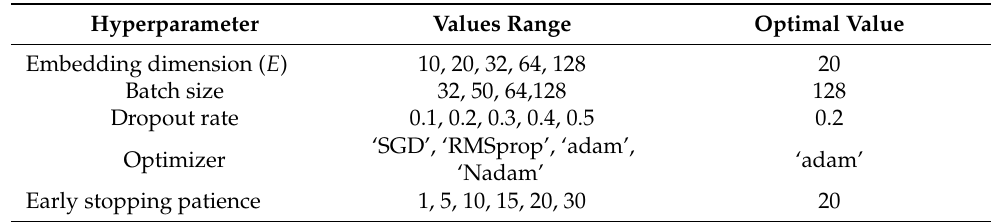
Table 5. Hyperparameter Setting.